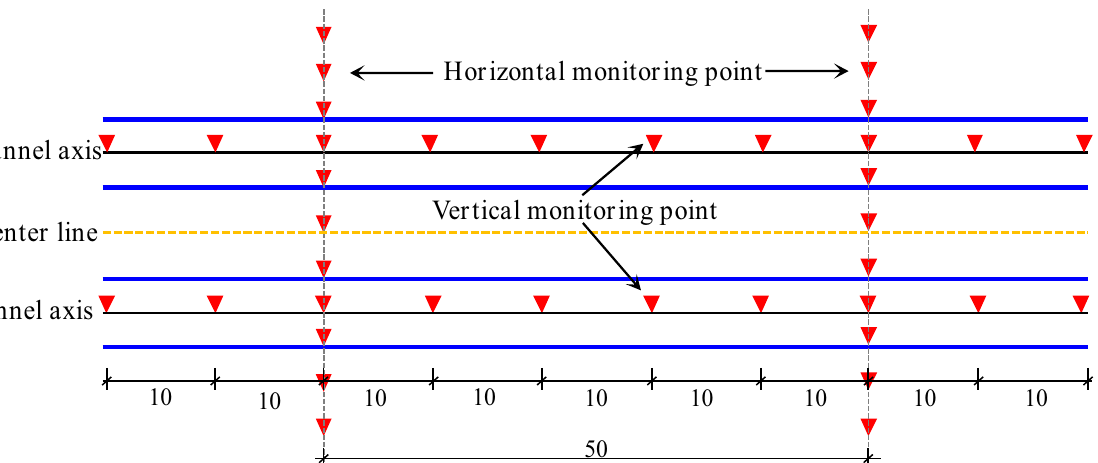
Figure 3. Plan view of the settlement monitoring points in the shield tunnel.